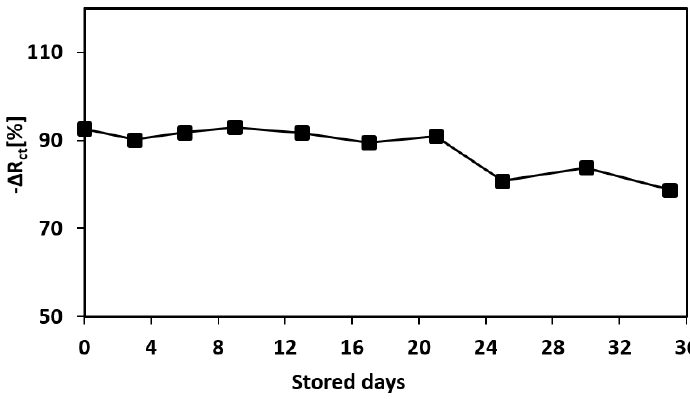
Figure 13. Shelf-life of the fabricated aptamer-based biosensor. The sensor response is plotted against the number of stored days at room temperature.